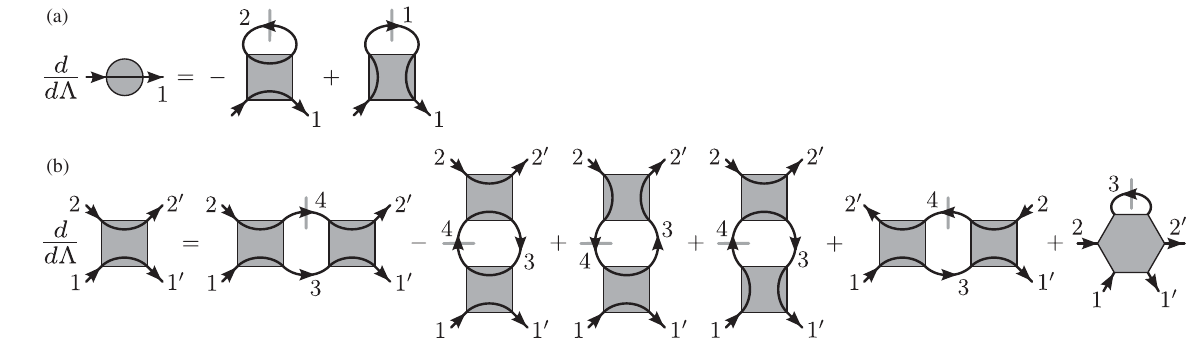
FIG. 2. Diagrammatic representation of the PFFRG equations for (a) the self-energy Σ Λ ð i ω Þ (gray disk) and (b) the two-particle vertex Γ Λ ð 1 0 ; 2 0 ; 1 ; 2 Þ (gray squares). Arrows denote the fully dressed propagator G Λ ð i ω Þ , and slashed arrows denote the single-scale propagator S Λ ð i ω Þ . The gray hexagon in (b) is the three-particle vertex. Note that the right-hand side of (b) contains additional terms where the slashes in the first to fifth terms appear in the respective other propagator. For a spin- S generalization, the first term on the right-hand side of (a) and the second term in (b) are multiplied with a factor of 2 S